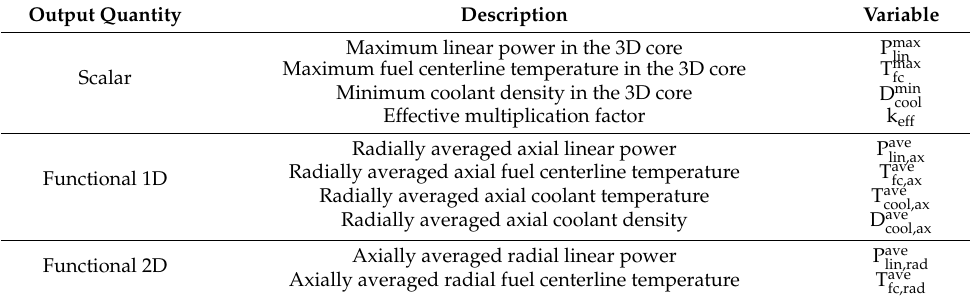
Table 5. Output quantities for steady-state calculations.